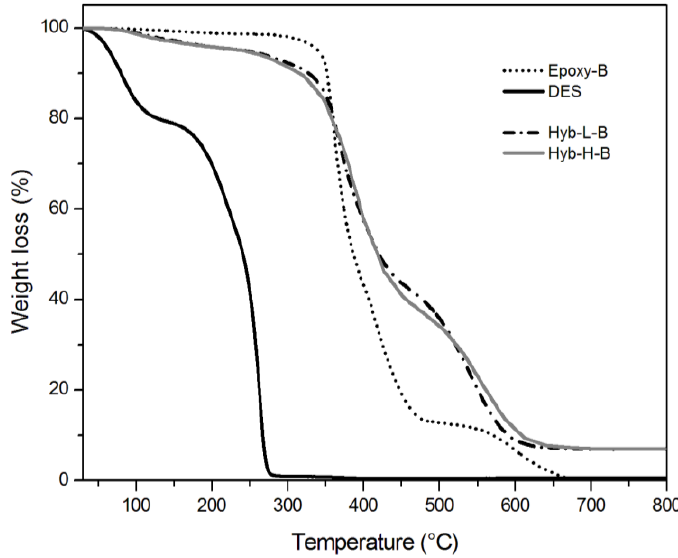
Figure 9. TGA thermograms of Epoxy-B and Hyb-H-B systems heated at 10 °C/min in oxidant atmosphere.